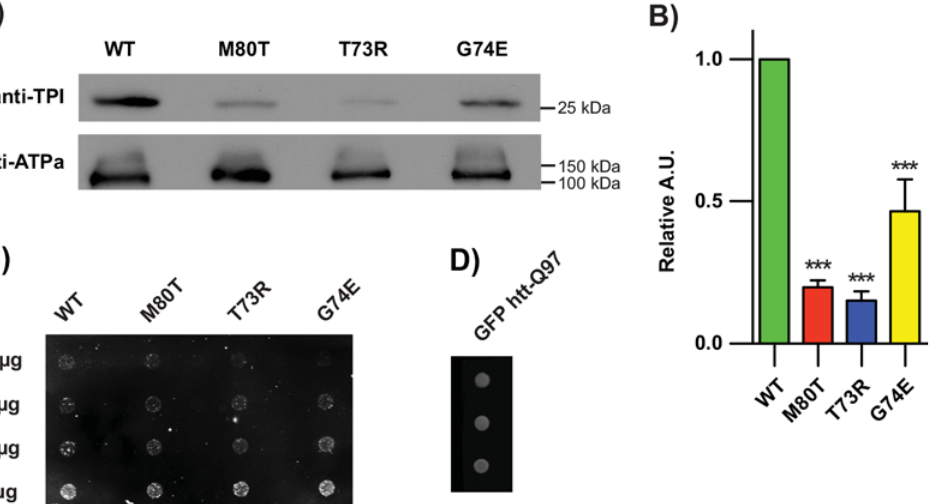
Fig 3. Mutations at the TPI dimer interface reduce TPI levels in vivo without aggregation. (A) dTPI T73R and dTPI G74E homozygote animal lysates display reduced protein levels with (B ) quantification normalized to WT and an ATPalpha loading control, n = 3. (C) The reduction in SDS-soluble TPI is not caused by protein aggregation; increasing amounts of lysate were loaded and show no differences in filter-trapped TPI across all genotypes, (D) 10 μ g of huntingtin exon1-GFP lysate displayed robust retention on the filter, n = 2. Comparisons were made with a One-way ANOVA using Tukey ’ s post hoc test, *** p < 0.001 relative to